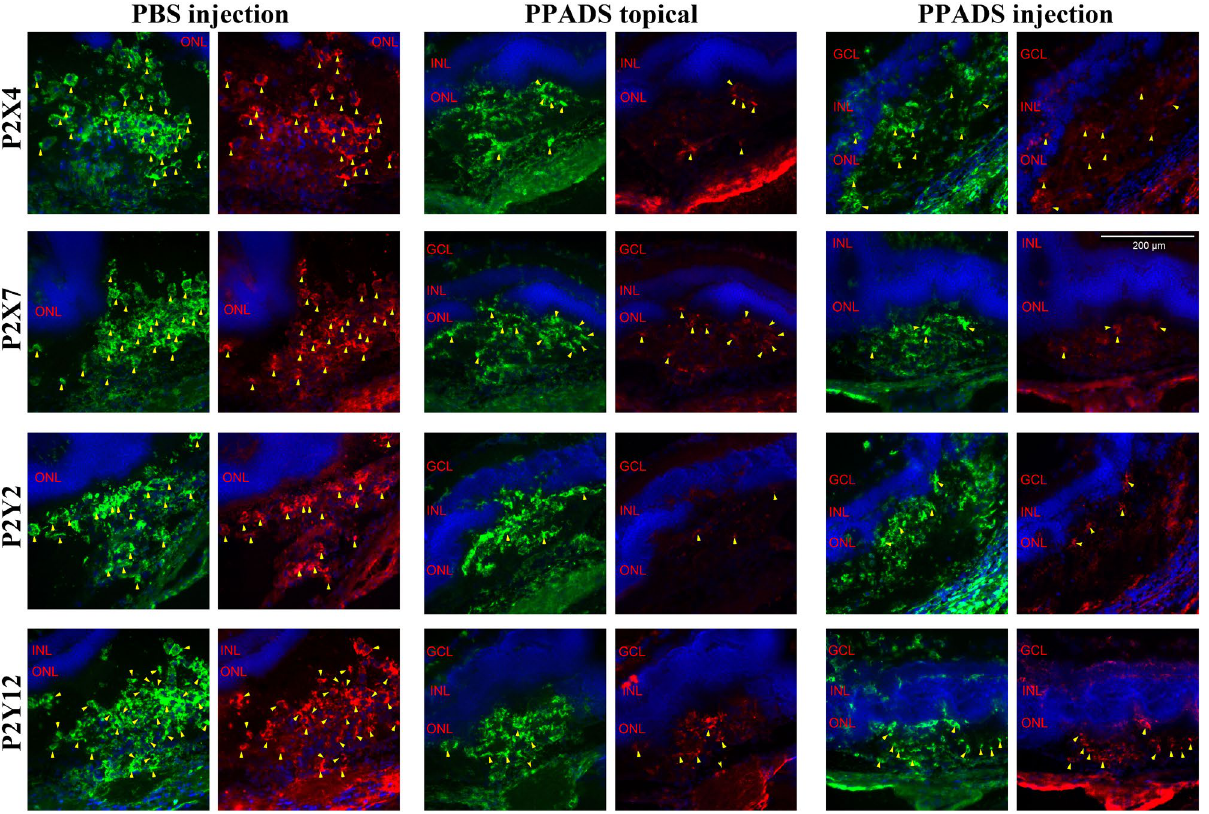
time. Scale bar: 200